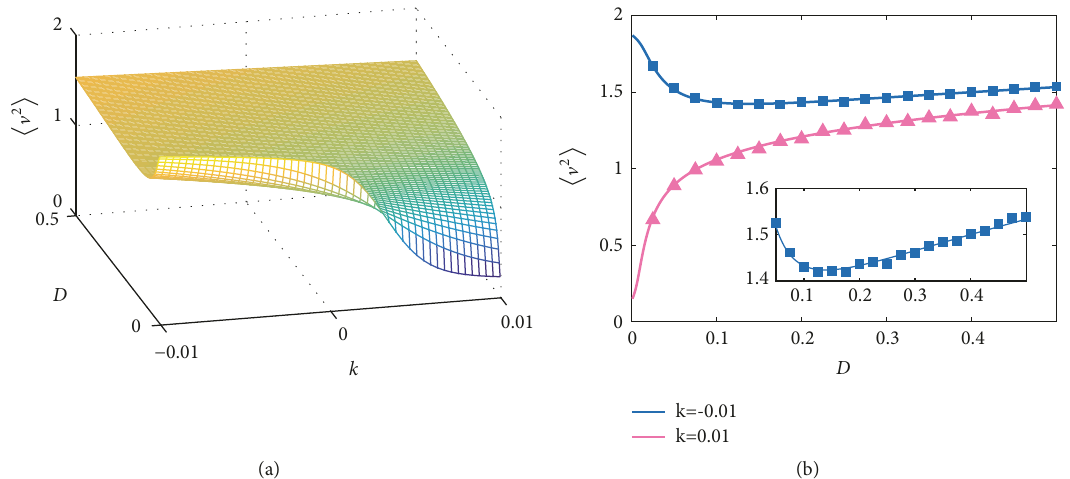
Figure 8: The dependence of the mean square electric voltage ⟨ V 2 ⟩ on 𝐷 and 𝑘 . Solid lines are the analytical results; symbols result from numerical simulations.